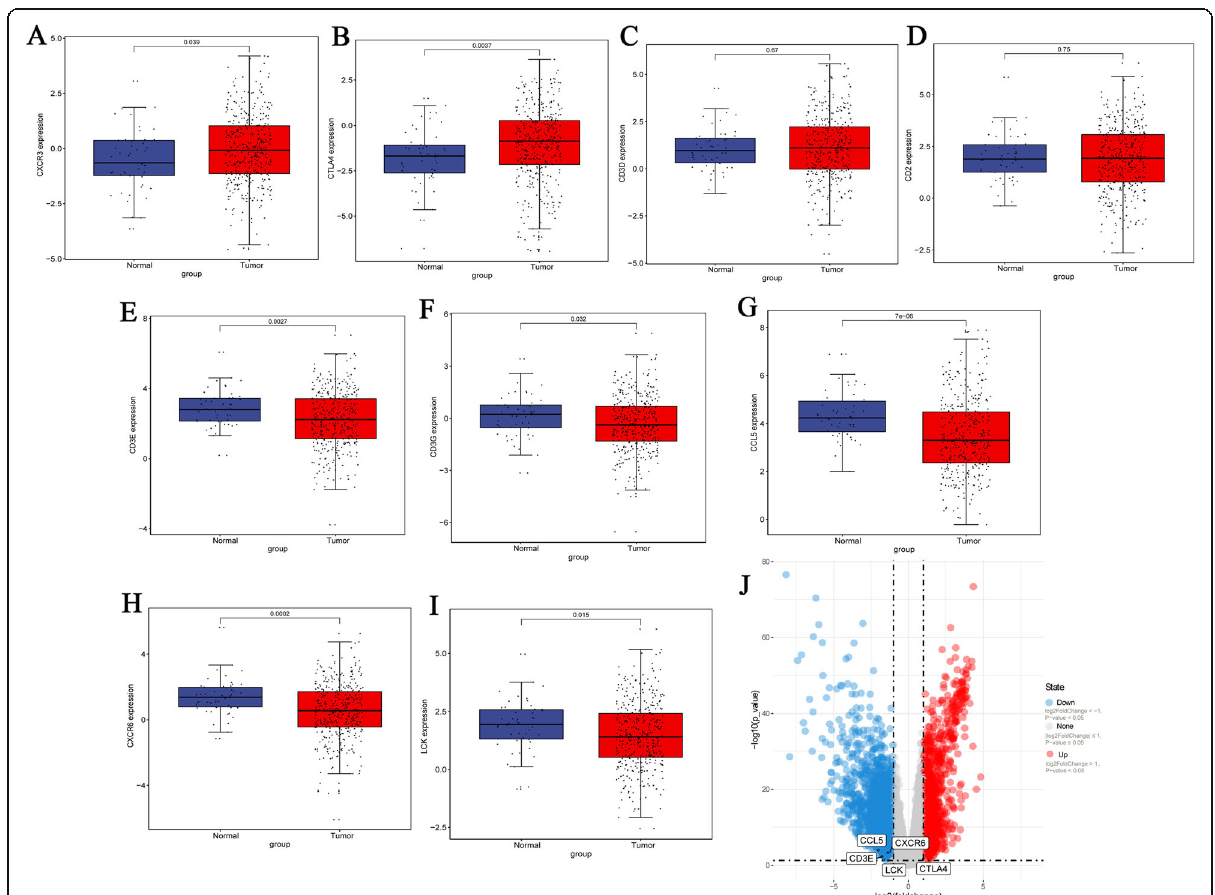
Fig. 7 Verification of hub genes expression in HCC samples and adjacent non-tumor samples using the TCGA database. A - I Differential expression of CXCR3, CTLA4, CD3D, CD2, CD3E, CD3G, CCL5, CXCR6 and LCK in normal and tumor samples. Normal and Tumor indicate adjacent non-tumor samples and HCC samples, respectively. P <0.05 was considered to indicate a statistically significant difference. J Volcano plot of differentially expressed genes in the adjacent non-tumor samples and HCC samples. Red dots, blue dots and black circles represent up-regulated genes, down- regulated and hub genes, respectively. P <0.05 and |log2FC|>1 was used to identify differentially expressed genes. HCC: hepatocellular